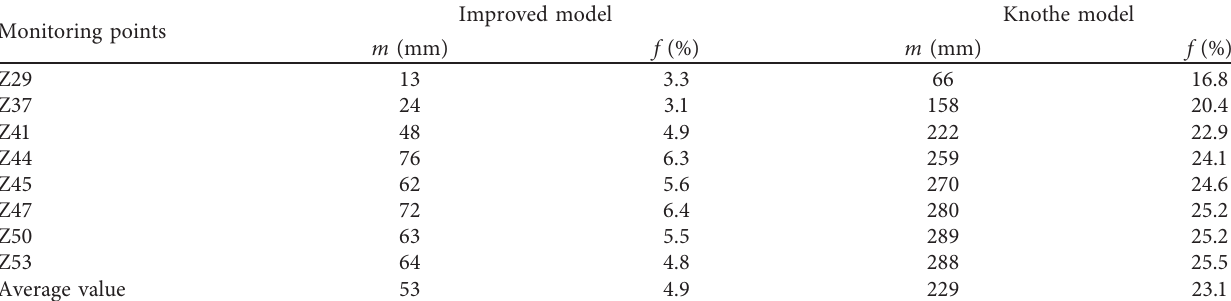
Table 3: Error of monitored and predicted